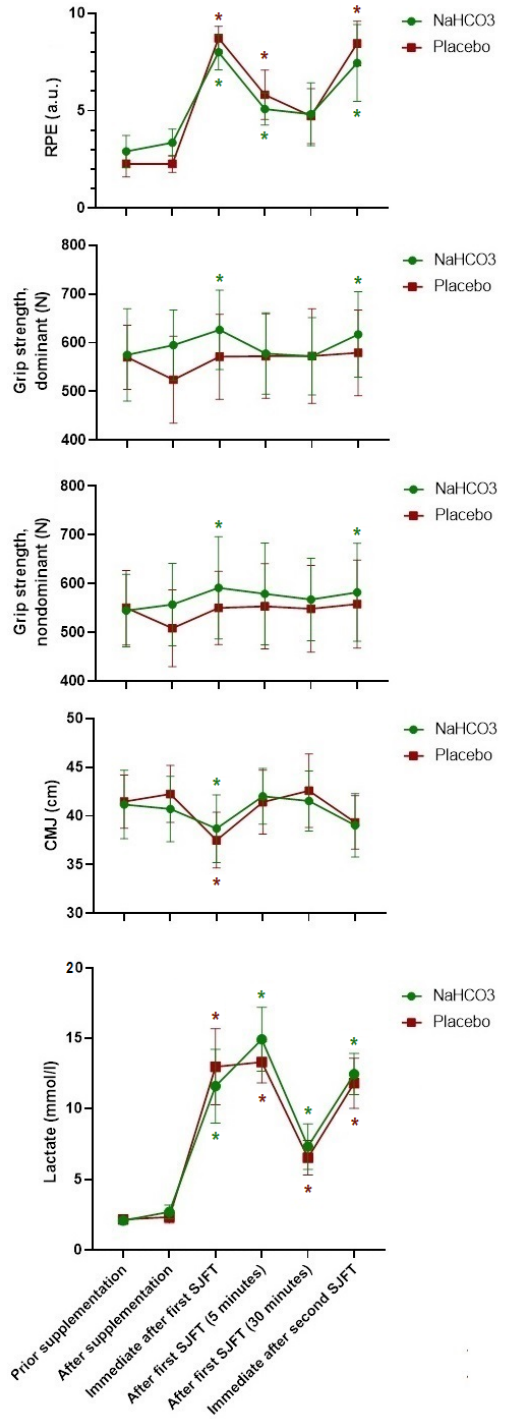
Figure 1. Performance and lactate responses before and after an SJFT. Significance differences with p < 0.05 (*) compared to “After p < 0.05 (*) compared to “After supplementation”.